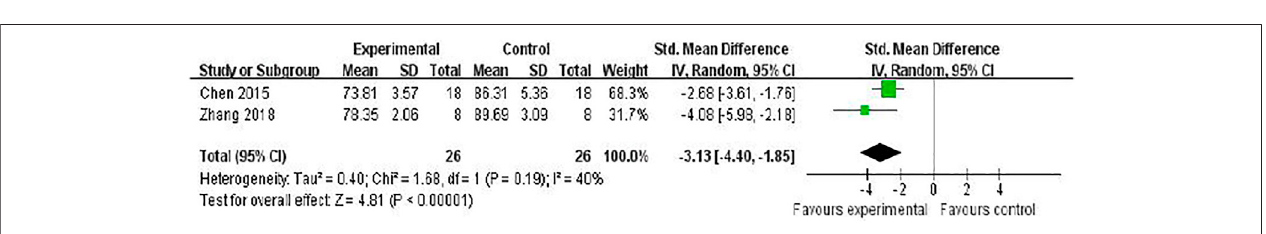
FIGURE 3 | The pooled estimate of RRC for improving brain water